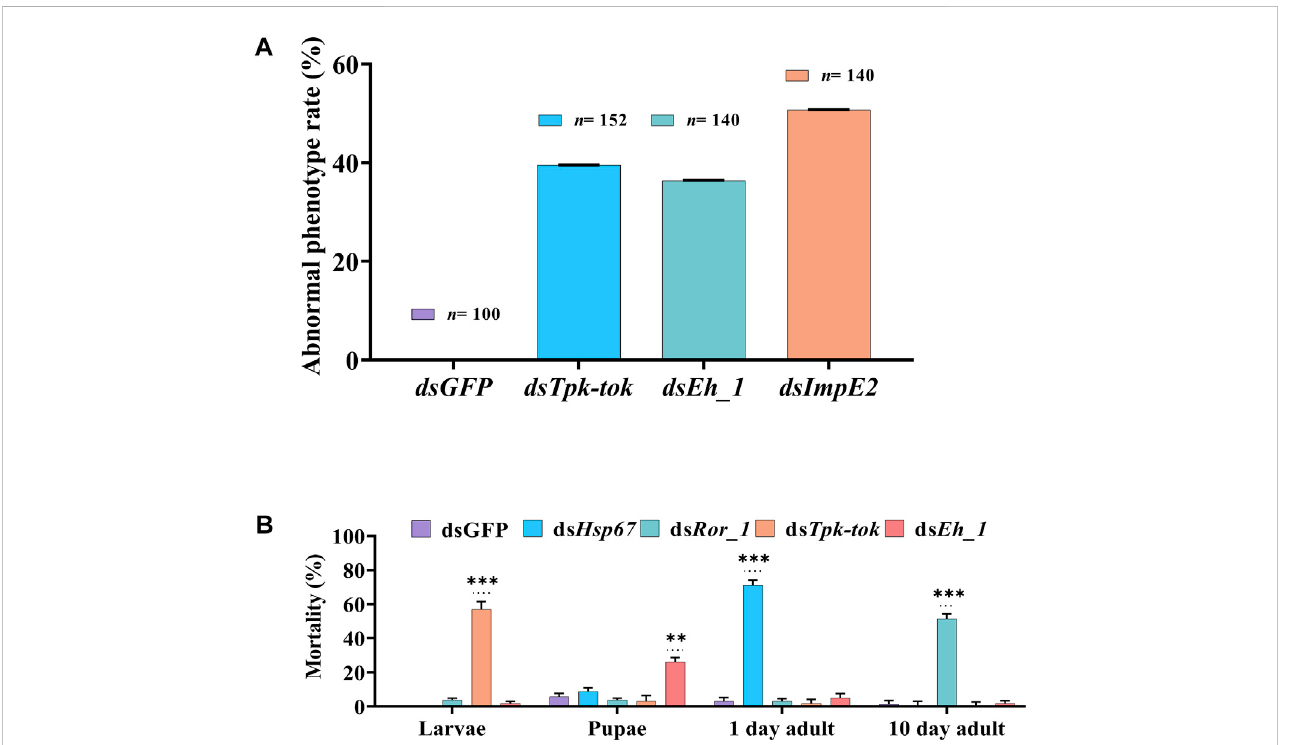
FIGURE 5 Abnormal phenotypes and Mortality observed in different developmental stages of Z. cucurbitae . (A) Percentage of observed abnormalities after dsRNA delivery of target genes and dsGFP (Control). (B) Percentage of insect mortality post feeding dsRNA of target genes compared to the control group. Values represent means%±SD.Data wereanalysedusing Duncan ’ stest.* p < .05; ** p < .01;*** p < .001; ns nostatisticallysigni fi